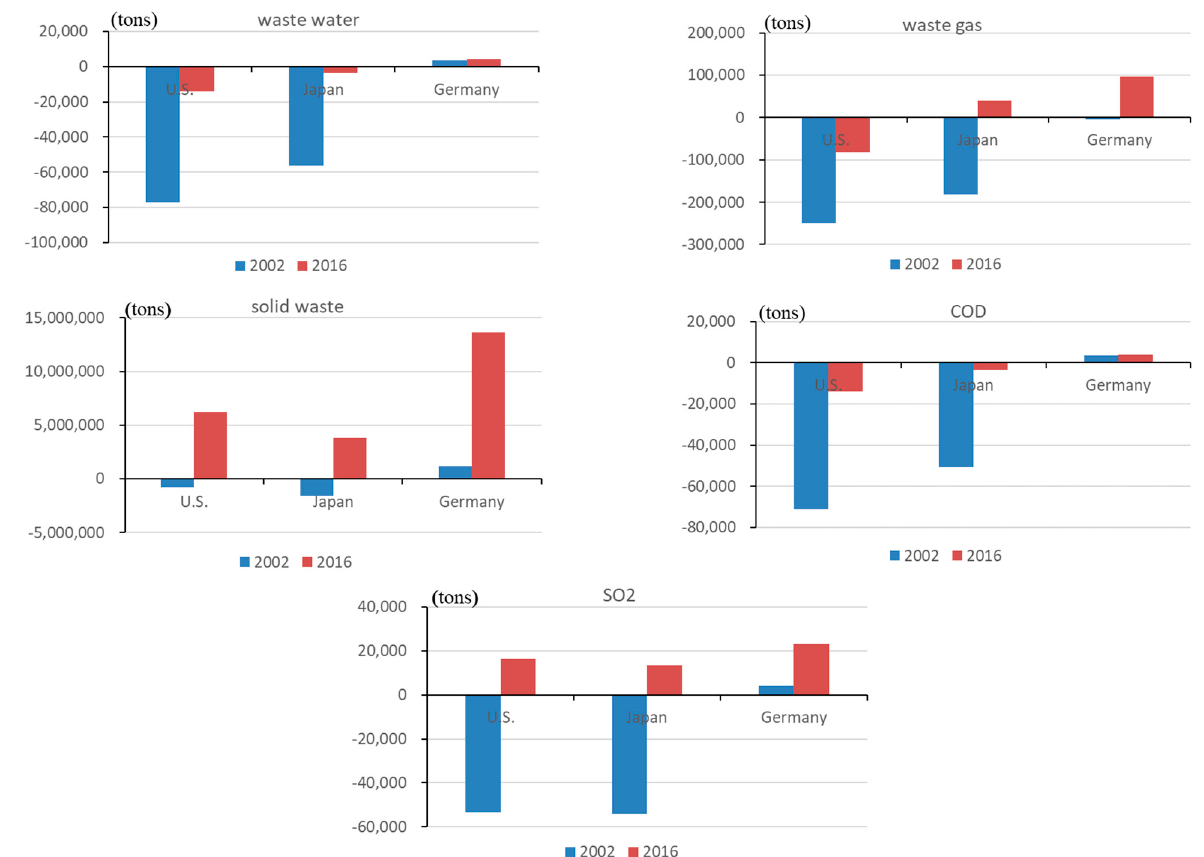
Figure 5. The revised BEET between China and US, Japan, and Germany (unit: tons).